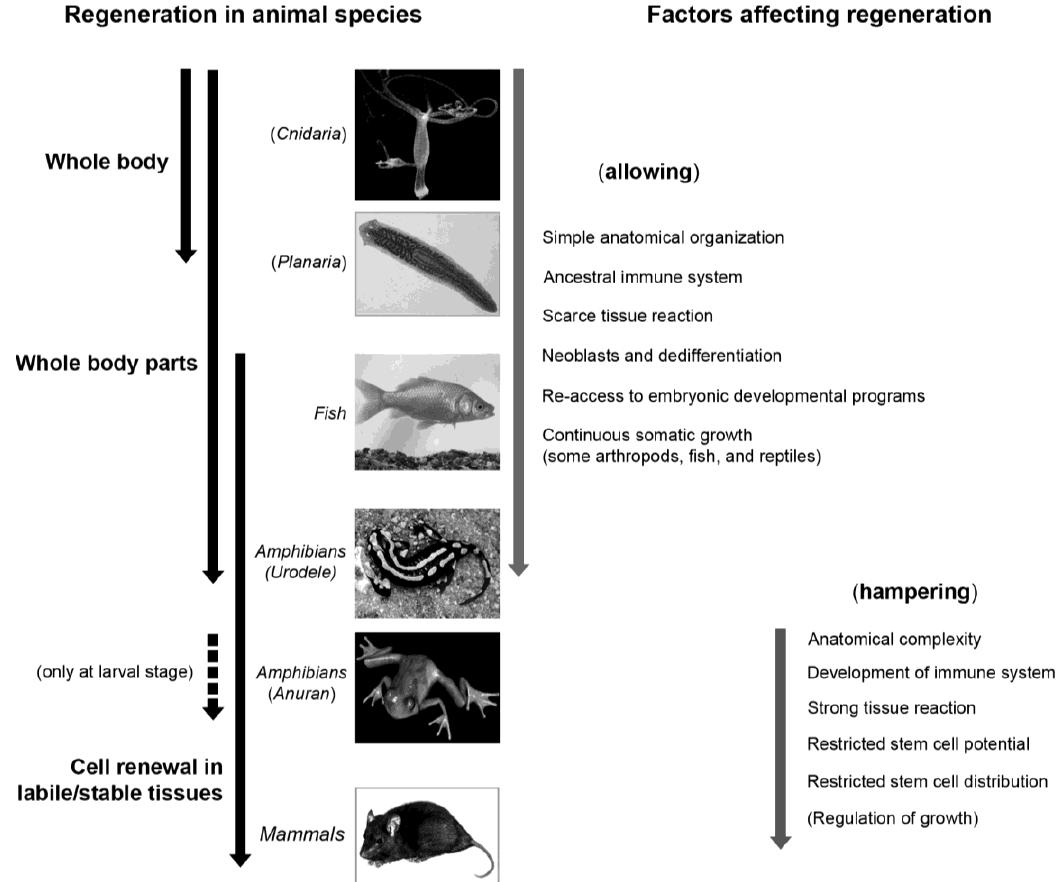
FIGURE 1. Schematic representation of the progressive restriction of regenerative capacity in different animal species, put in relation with several